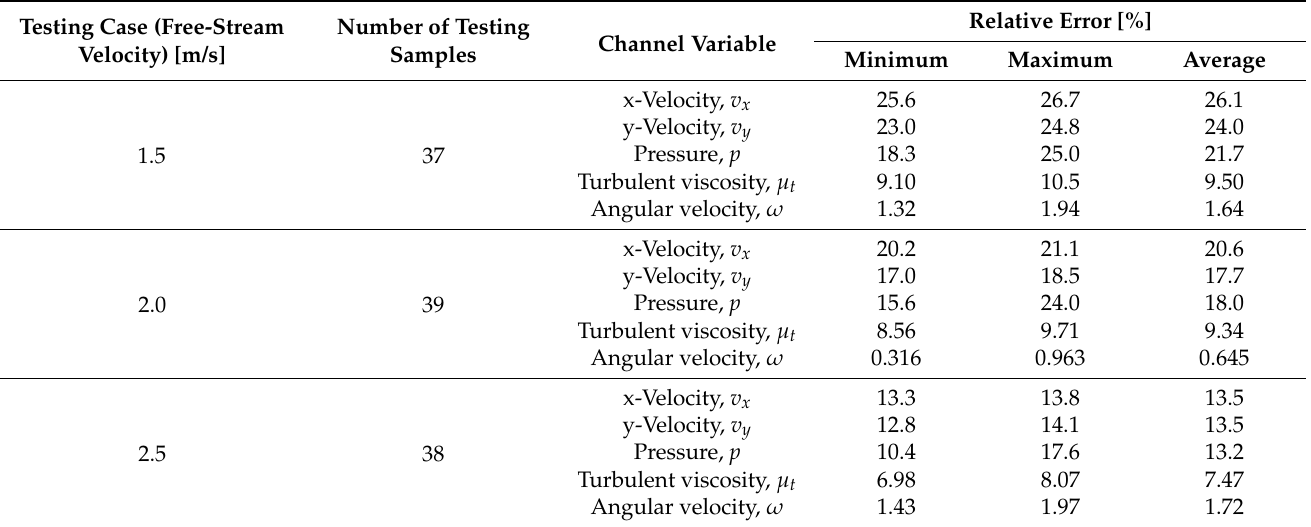
Table 6. Relative errors produced by Model 2 in each channel, for the individual testing cases of v ∞ = 1.5, 2.0, and 2.5 m/s.